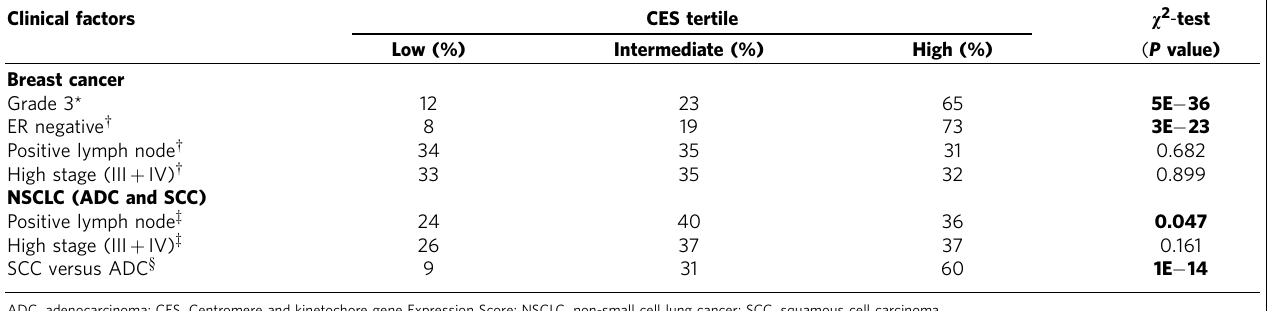
Table 2 | Distribution of specific tumour characteristics among CES tertiles. Clinical factors